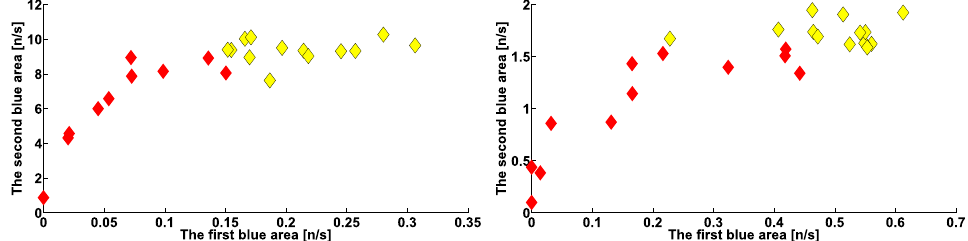
Figure 15. Scatter plots of number of cross-wave trains per second in arms with hyperkinetic movements in PD and ET patients. Red diamonds are PD patients. Yellow diamonds are ET patients. ( Left ), the left arms in frequency ranges of 2.2–3.9 Hz (abscissa axis) and 10–37 Hz (ordinate axis). ( Right ), the right arms in frequency ranges of 2.2–3.9 Hz (abscissa axis) and 12–37 Hz (ordinate